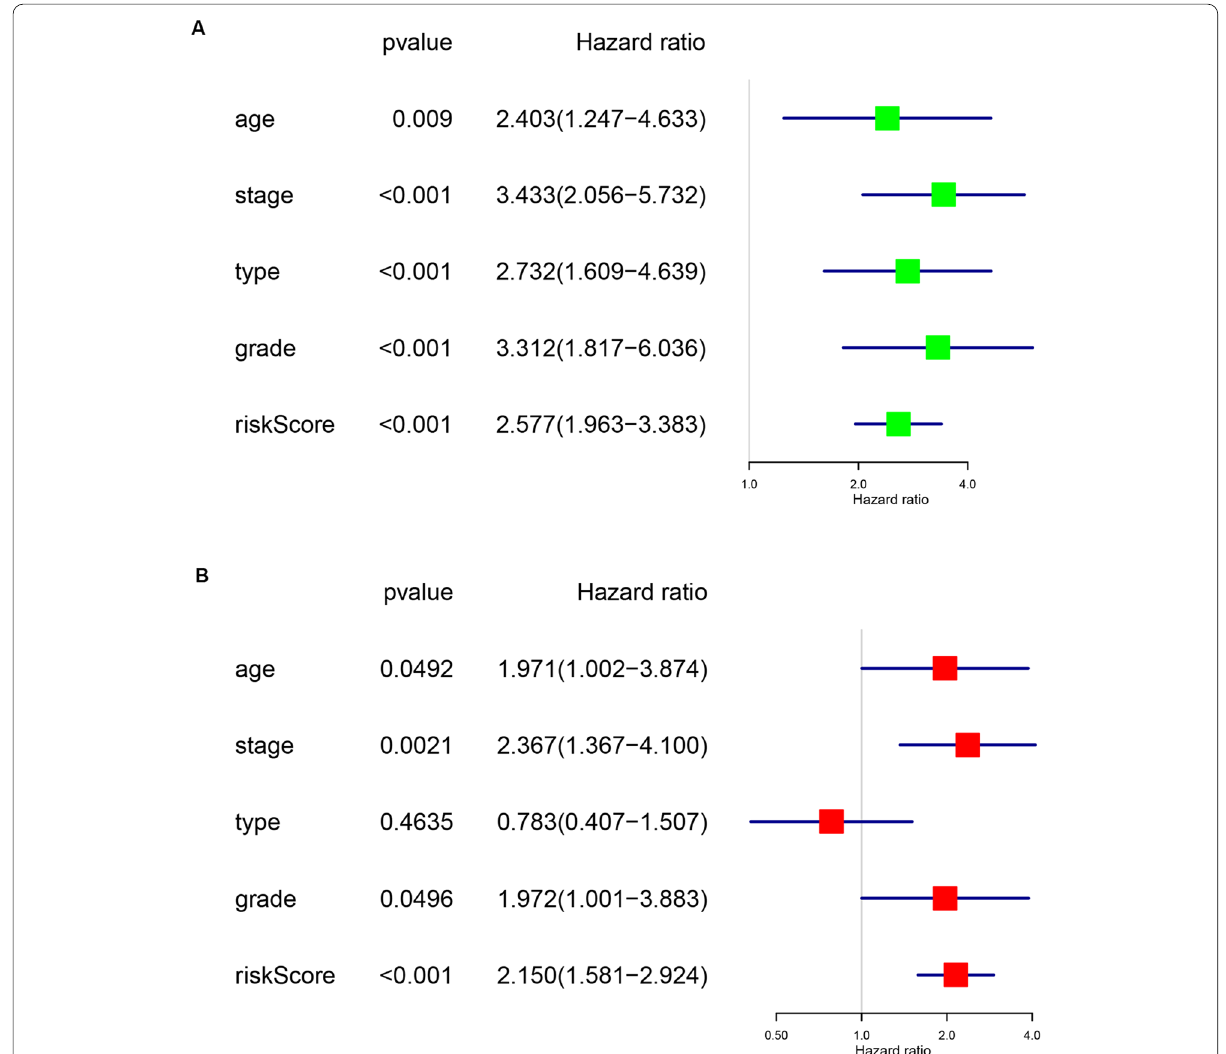
Fig. 3 Univariate ( A ) and multivariate ( B ) regression analyses of the prognostic value for